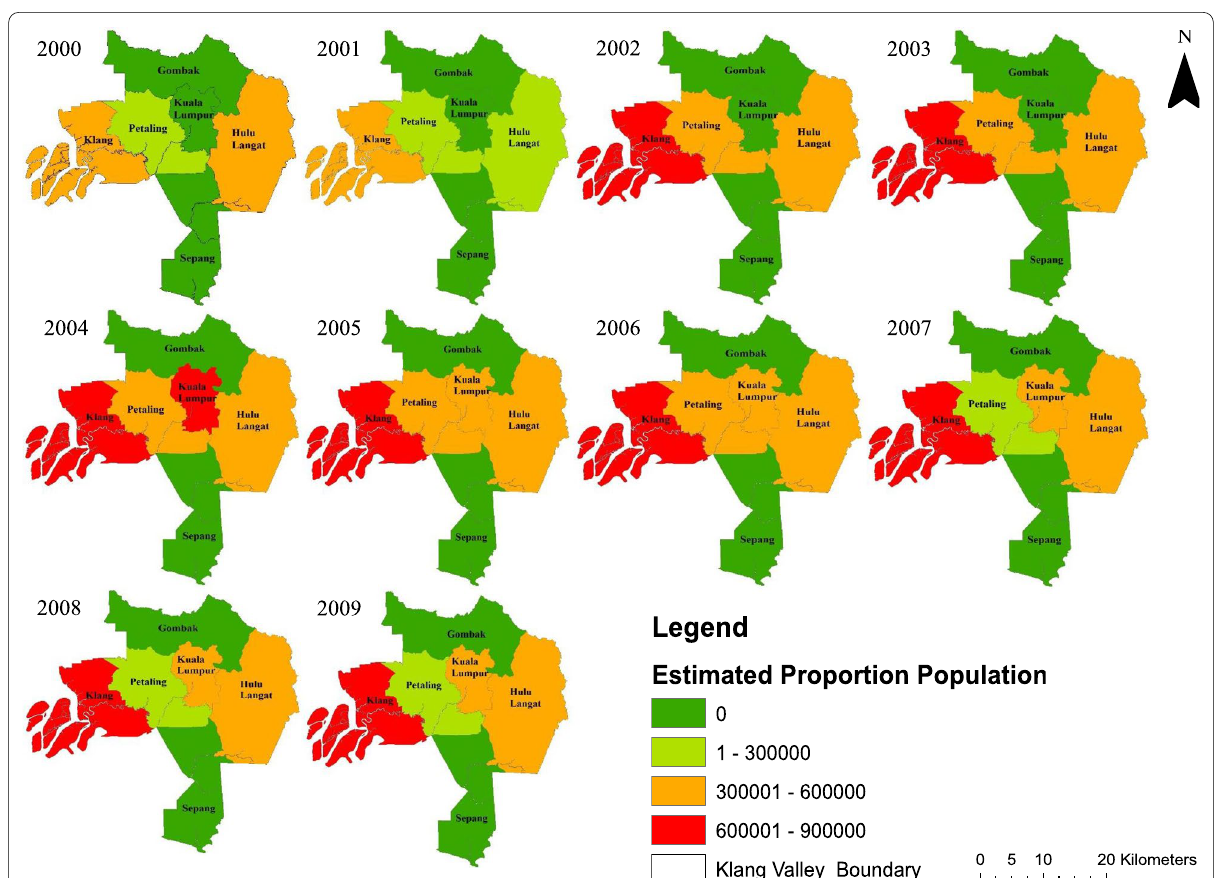
Fig. 6 Spatial estimated proportion among adult population (people) of chronic bronchitis disease at four districts in the Klang Valley: Klang district represented Klang DOE monitoring station, Petaling district (Shah Alam and Petaling Jaya stations), Kuala Lumpur district (Cheras station) and Hulu Langat district (Kajang station) from 2000 to 2009. Note Gombak and Sepang districts are not included